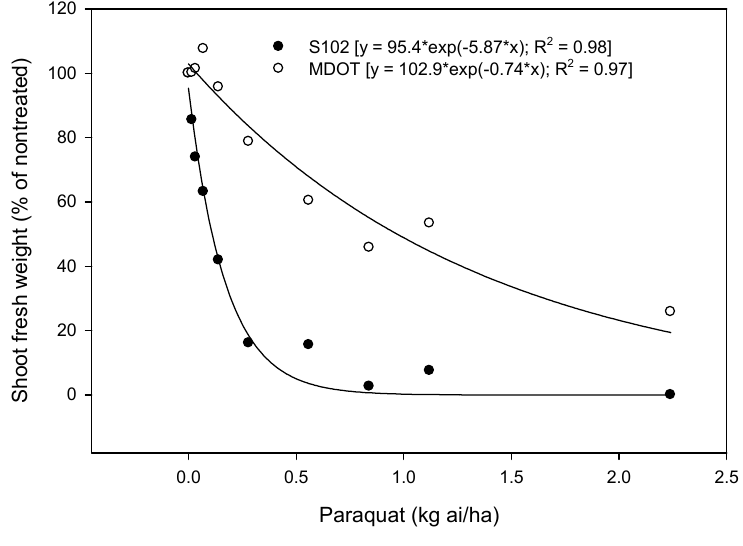
Figure 2. Paraquat dose response on above ground shoot growth of resistant (MDOT) and susceptible (S102) horseweed populations. GR plant growth by 50%) values for MDOT and S102 populations were 0.67 and 0.078 kg ai/ha paraquat,